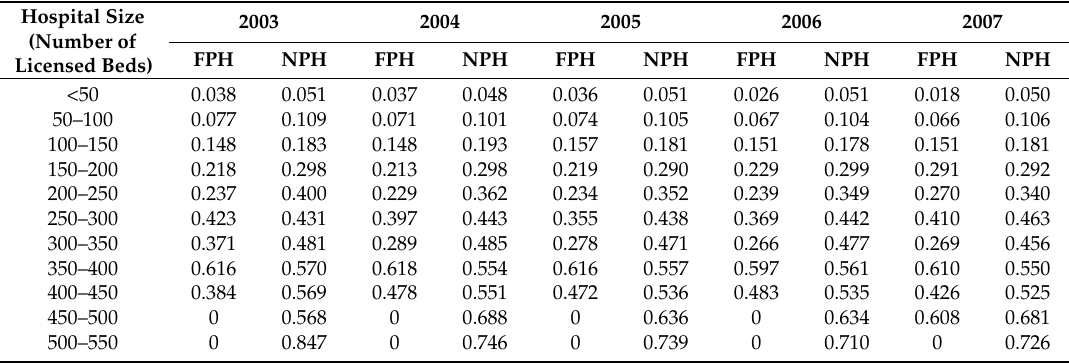
Table 2. Average Market Share (Percentage) of California General Hospitals with Licensed Beds by Ownership